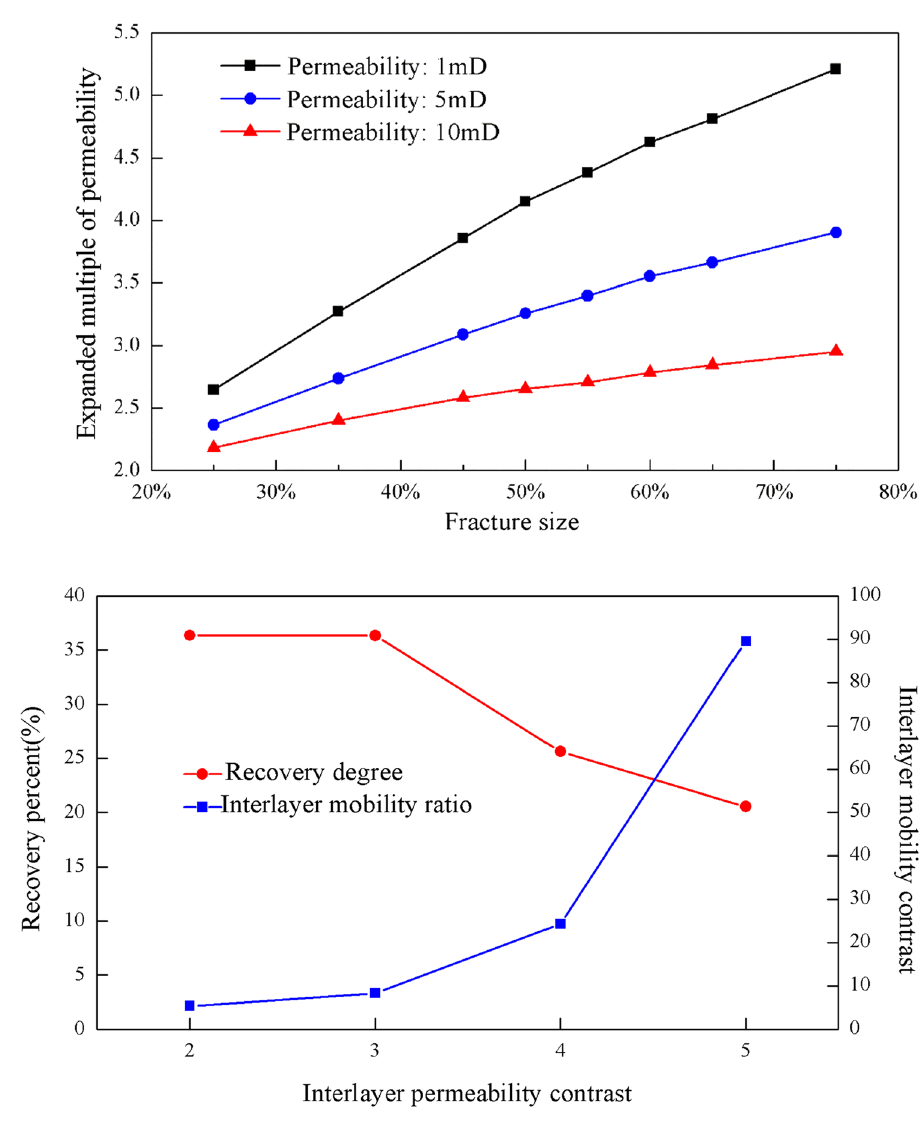
Fig. 6 Expanded multiples of average permeability